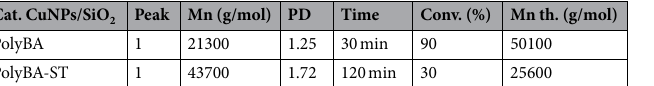
Table 3. GPC data for block poly(n butyl acrylate-block-styrene) obtained using CuNPs/SiO 2 catalyst and Me